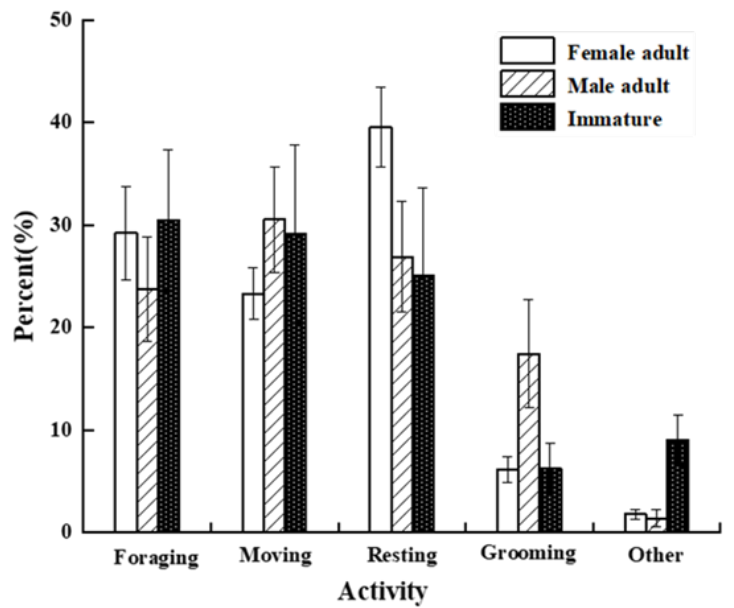
Figure 4. Food, temperature, and time budget correlation.